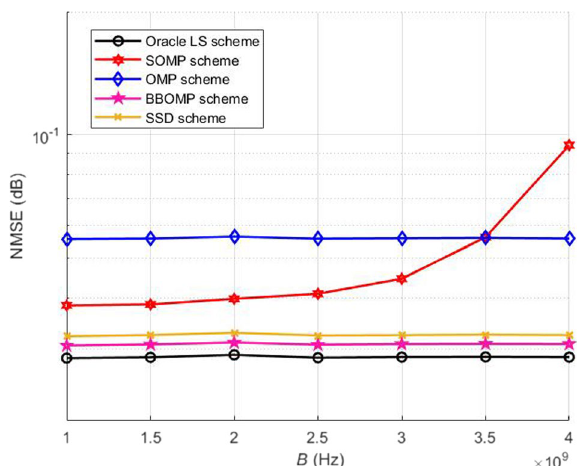
Fig. 5 The NMSE performance of different schemes versus the number of users K . a . SNR dB